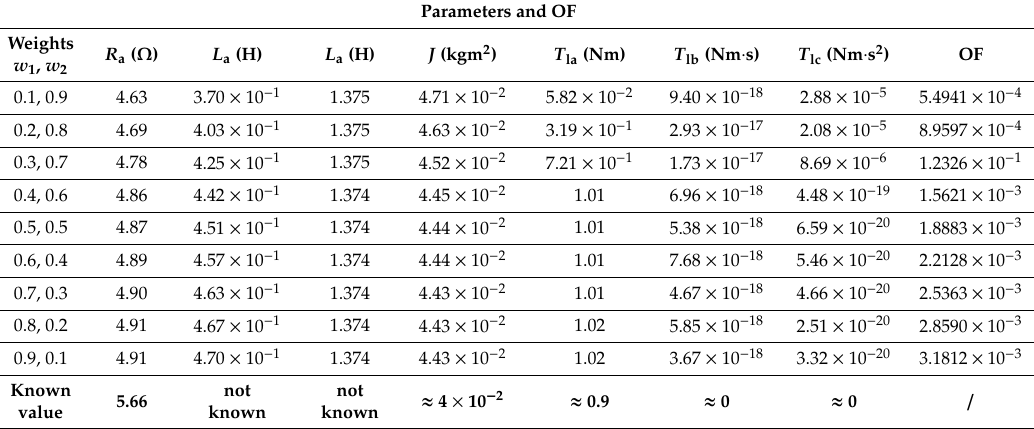
Table 22. Calculated parameters with di ff erent weights using RK for MD3 (mean values for 50 independent runs).